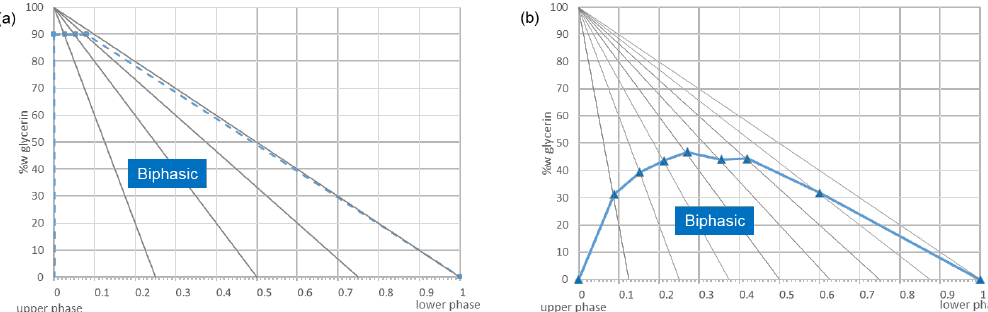
Figure 2. Ternary diagram of upper phase, lower phase, and glycerin ( w / w / w ) for the solvent systems: ( a ) ethyl acetate (EtOAc) / acetonitrile (CH 3 CN) / water 3:3:4 ( v / v / v ) and ( b ) n -butanol (n-BuOH) / acetic acid / water 4:1:5 ( v / v / v ) as an example of appropriate ( a ) and inappropriate ( b ) solvent systems for our physical glycerin suppression strategy. Demixing points are symbolized by triangles. In ( a ), no demixing point was observed until the addition of 90% wt. of glycerin (maximum points studied symbolized by squares). Experiments were performed at 20 °C.